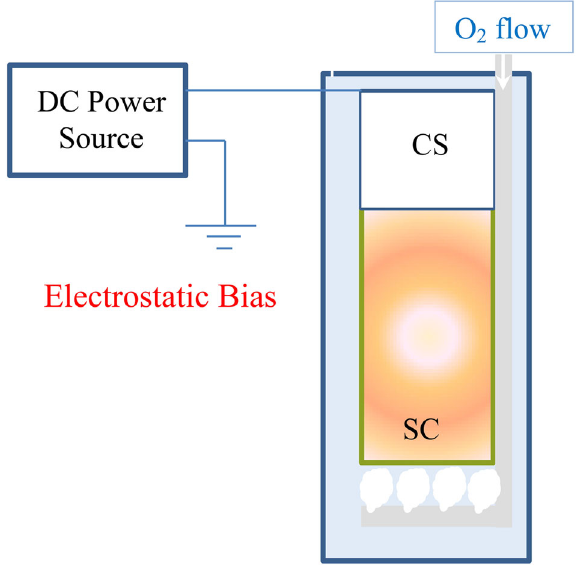
Fig. 6 Schematic representation of the single-electrode photo- electrostatic setup. This system was used for photo-electrostatic degradation/decolorization of ionic dyes in aqueous media (CS conducting substrate, SC